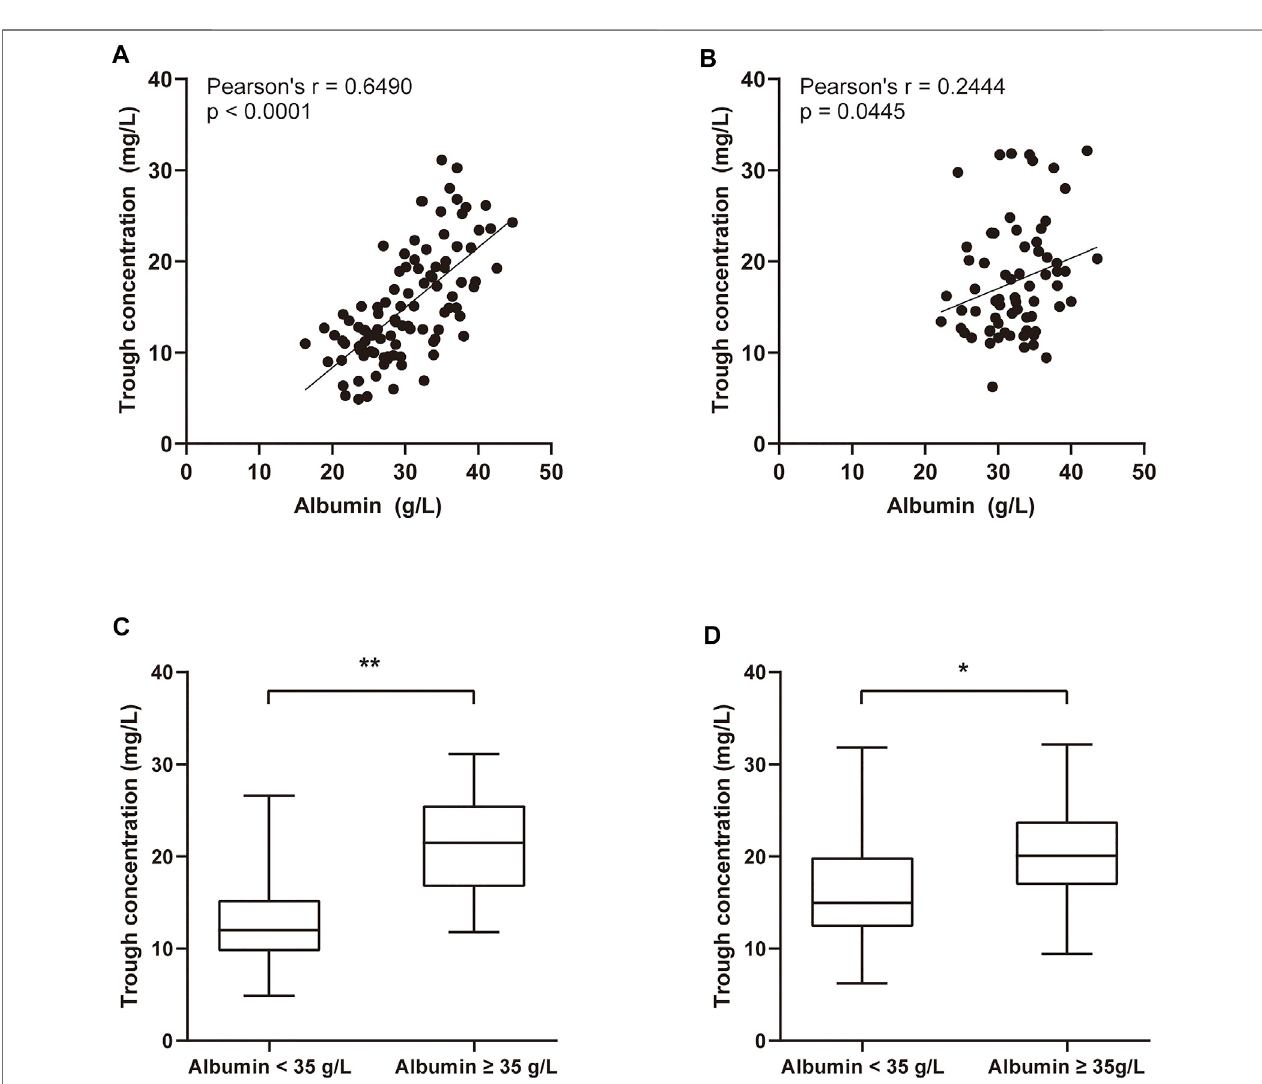
FIGURE 3 | The linear regression analysis was used to compare the correlation between the albumin level and C min of TEI. (A) The correlation coef fi cient (r) was 0.6490 between the C min before the 3rd dose and the albumin level before the start of TEI administration ( p < 0.001). (B) The correlation coef fi cient (r) was 0.2444 between the